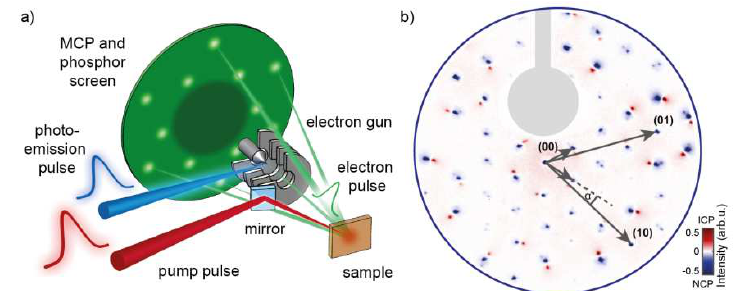
Fig. 1. a, Sketch of the optical-pump electron-probe scheme of the ULEED experiment. b, Difference image of the NC (blue) and IC (red) diffraction patterns (adapted from Ref. [3]).